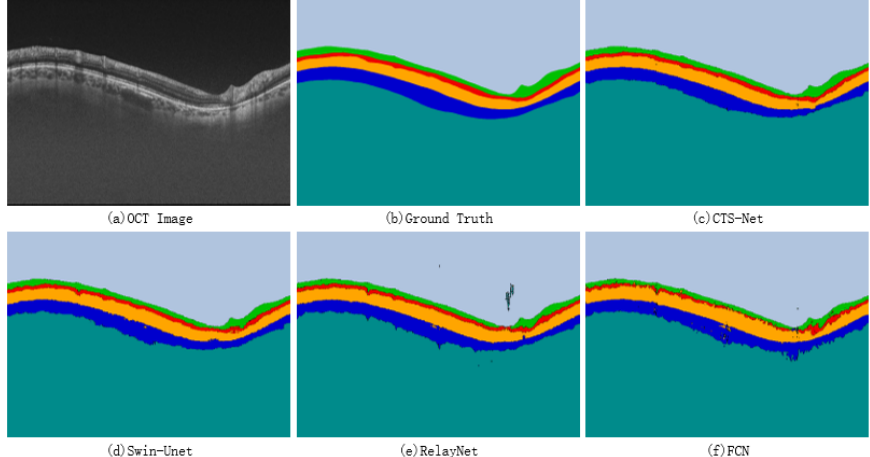
Figure 8. Retinal layer segmentation results for four